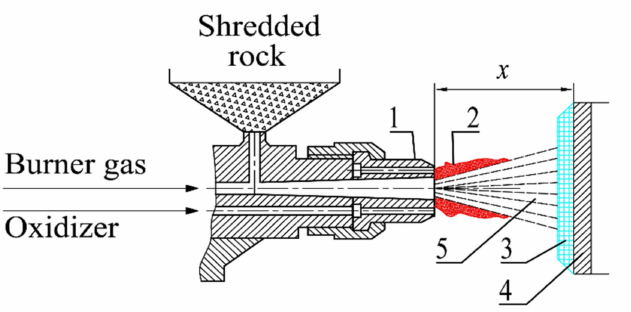
Figure 3. Spraying of a capillary-porous coating: 1—nozzle; 2—gas flame; 3—capillary-porous coating; 4—sprayed surface; 5—dispersed particles (quartz, granite, tesenit); x —is the distance determined by experience, depending on the mineral medium